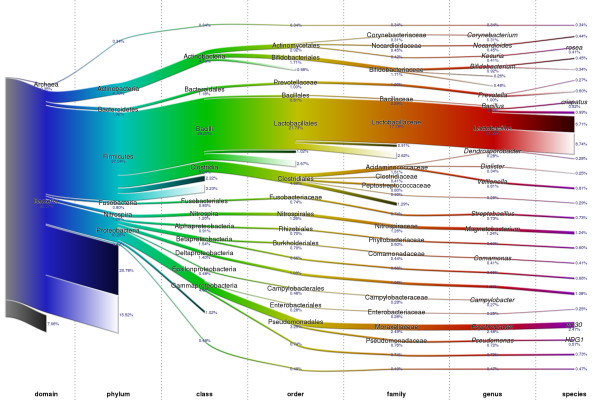
Combined sample phylogenetic content. The proposed methodology was applied to the reads obtained from six samples and results were aggregated in a single tree. Branch widths indicate the proportion of reads assigned down those branches in the phylogeny. Branches fading into white represent reads that are resolution limited due to similarity among multiple sub-branches in the phylogeny. Branches fading into black represent reads that do not have full-length homology with any known 16S sequence.